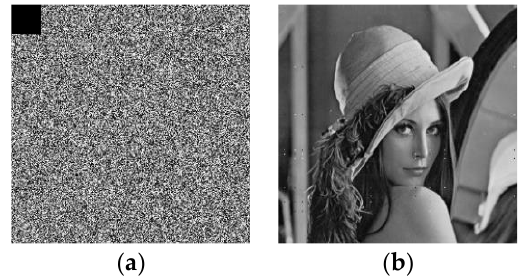
Figure 14. The removal of a 32 × 32 sub block: ( a ) encrypted image and ( b ) decrypted image.